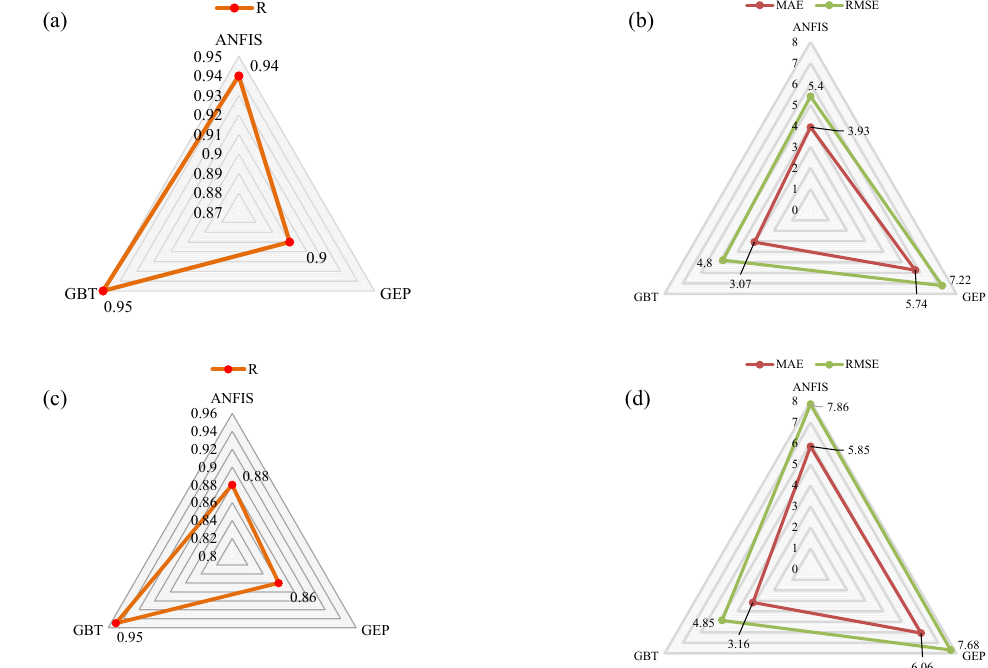
Figure 12. Comparison of the developed models based on various statistical evaluation indices using radar plots. R values ( a , c ); MAE and RMSE values ( b , d )